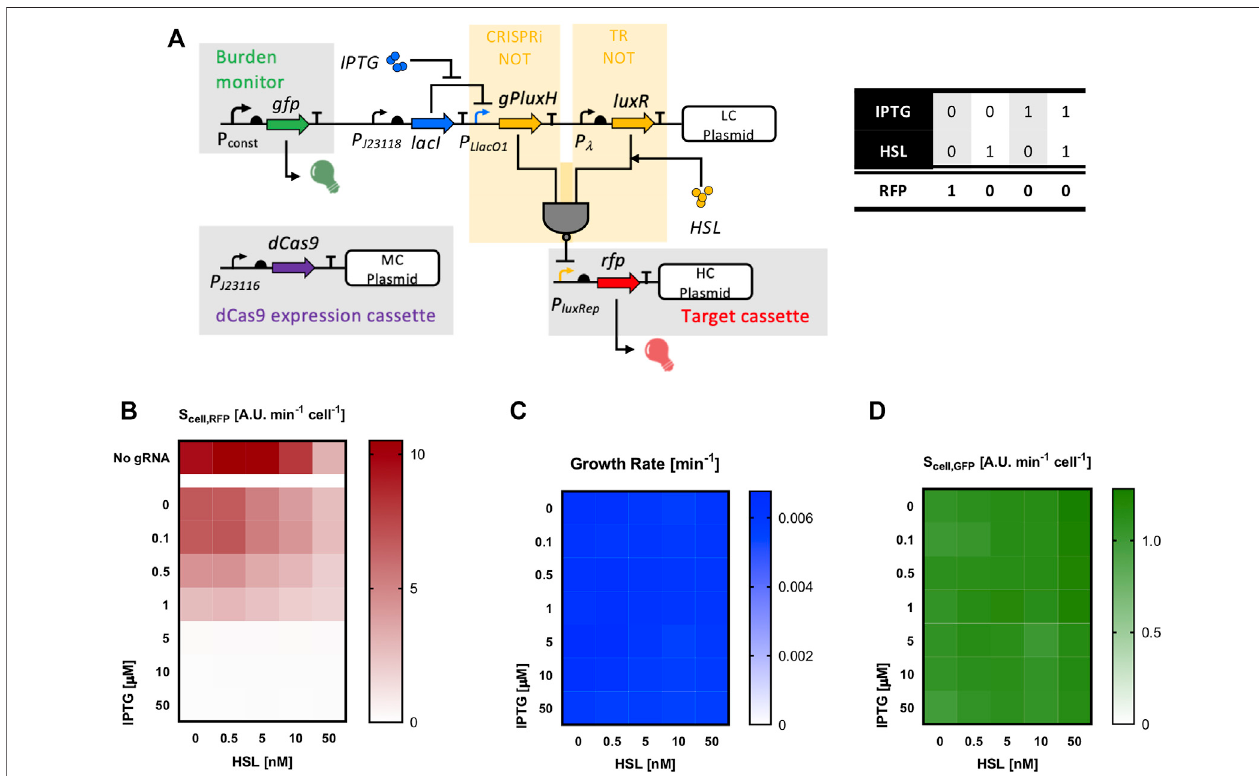
FIGURE 8 | A NOR gate derived from a transcriptional regulator-based NOT gate and an additional CRISPRi logic inverter. (A) The HSL-dependent LuxR-based NOT gate (transcriptional regulator — TR — NOT) is shown in the upper-right and lower-right part of the panel, while the IPTG-dependent CRISPRi NOT gate is reported on the left. The resulting truth table with IPTG and HSL as inputs and with RFP as output is also reported. (B – D) RFP, growth rate and GFP values as a function of IPTG and HSL.